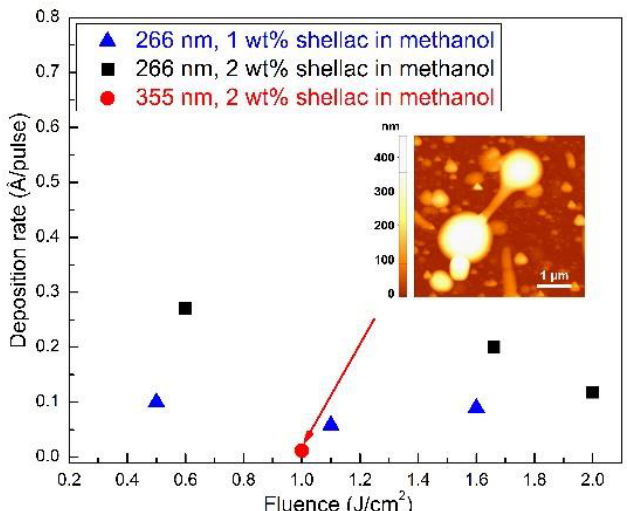
Figure 2. Dependence of shellac deposition rate on the laser fluence as resulting from profilometry on samples prepared by matrix-assisted pulsed laser evaporation (MAPLE). Inset AFM image on a shellac film deposited on an Si substrate using 355 nm laser wavelength as a result of 72,000 pulses at 1 J/cm 2 from a 2 wt % shellac in a methanol frozen target.